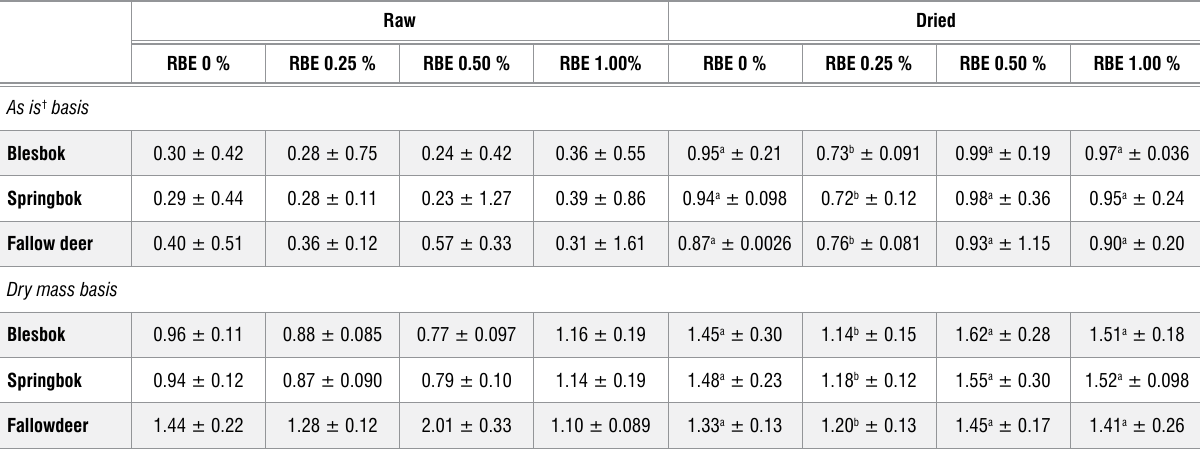
Lipid oxidation stage*treatment; LS Means Lipid oxidation results for blesbok, springbok and fallow deer droëwors Current effect: F(3, 18)=5.1919, p=.00926 are depicted in Table 5. The results for each species differed significantly Type III decomposition Vertical bars denote 0.95 confidence intervals from each other ( p =0.0231). It is important to note that as droëwors is a dried meat product, it is expected to undergo a large level of oxidation and therefore the TBARS values are expected to be higher than those found in raw meat. Therefore, the results are compared across treatments rather than between raw and dried samples. Blesbok species droëwors showed a general trend that after drying, each treatment had increased TBARS values, although the results also indicate that RBE 0.25% resulted in the lowest lipid oxidation and haem-iron concentration (Table 4) in blesbok species droëwors . The mean values for springbok species droëwors indicate that the TBARS values of the RBE-treated samples (0%, 0.25% and 0.50%) all increased with drying. RBE 1.0% decreases slightly (0.52 MDA per kg meat sample difference). As with the blesbok species droëwors , these results indicate that RBE 0.25% gave the best results in terms of minimum lipid oxidation. Fallow deer species droëwors mean values differed slightly from blesbok and springbok species droëwors , Figure 1: Haem-iron results indicating the interaction between stage and although the MDA levels fall within the same range as the blesbok and treatment apart from species ( p <0.05) for droëwors prepared springbok droëwors of both the raw and dried stages, except that the best result is shown to be at RBE with varying concentrations of rooibos extract (RBE). Table 4: Means±s.d. for haem-iron (mg haem-iron/g meat sample) of droëwors with added rooibos extract (RBE). Raw Dried RBE 0 % RBE 0.25 % RBE 0.50 % RBE 1.00% RBE 0 % RBE 0.25 % RBE 0.50 % RBE 1.00 %